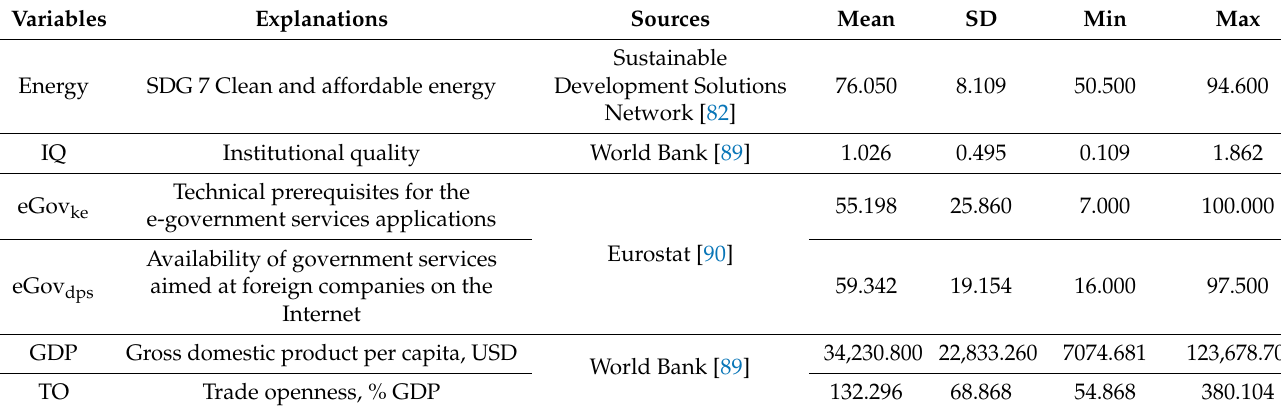
Table 2. The explanations and descriptive statistics of the dependent, independent, and control